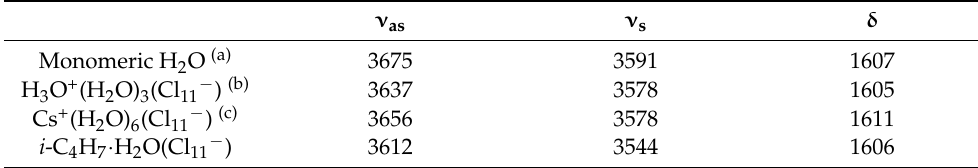
Table 5. IR frequencies of H 2 O molecules bonded to cations through